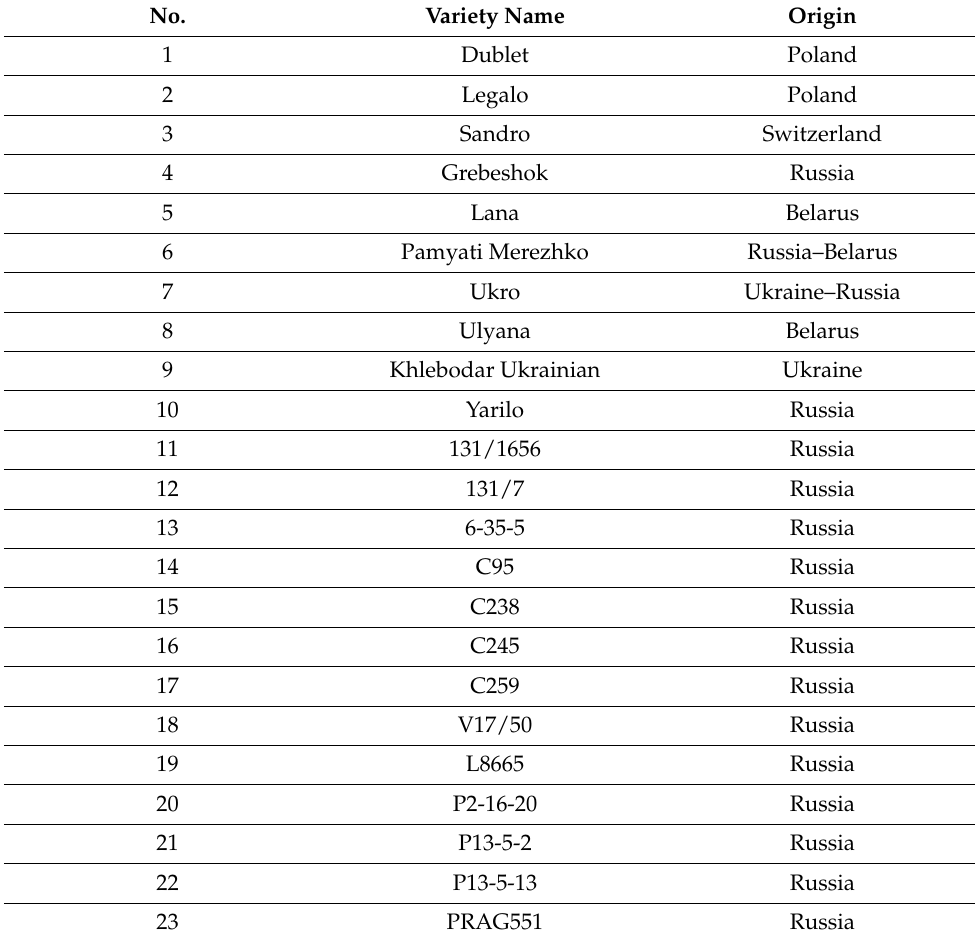
Table 1. The origin of the triticale collection lines used in this study. No.